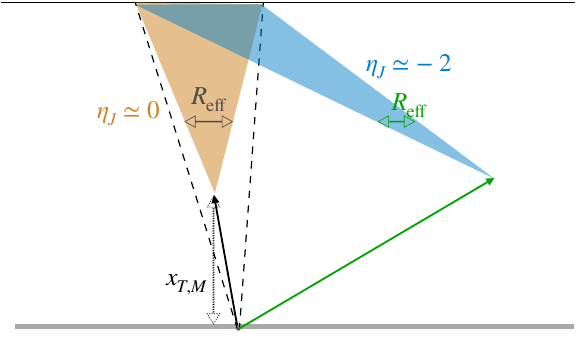
Figure 4 . Illustration of R eff effect for delayed jets. The brown shaded region has a larger R eff compared to the dashed lines because x is larger. The blue shaded region shows both the effect T,M of shifting and